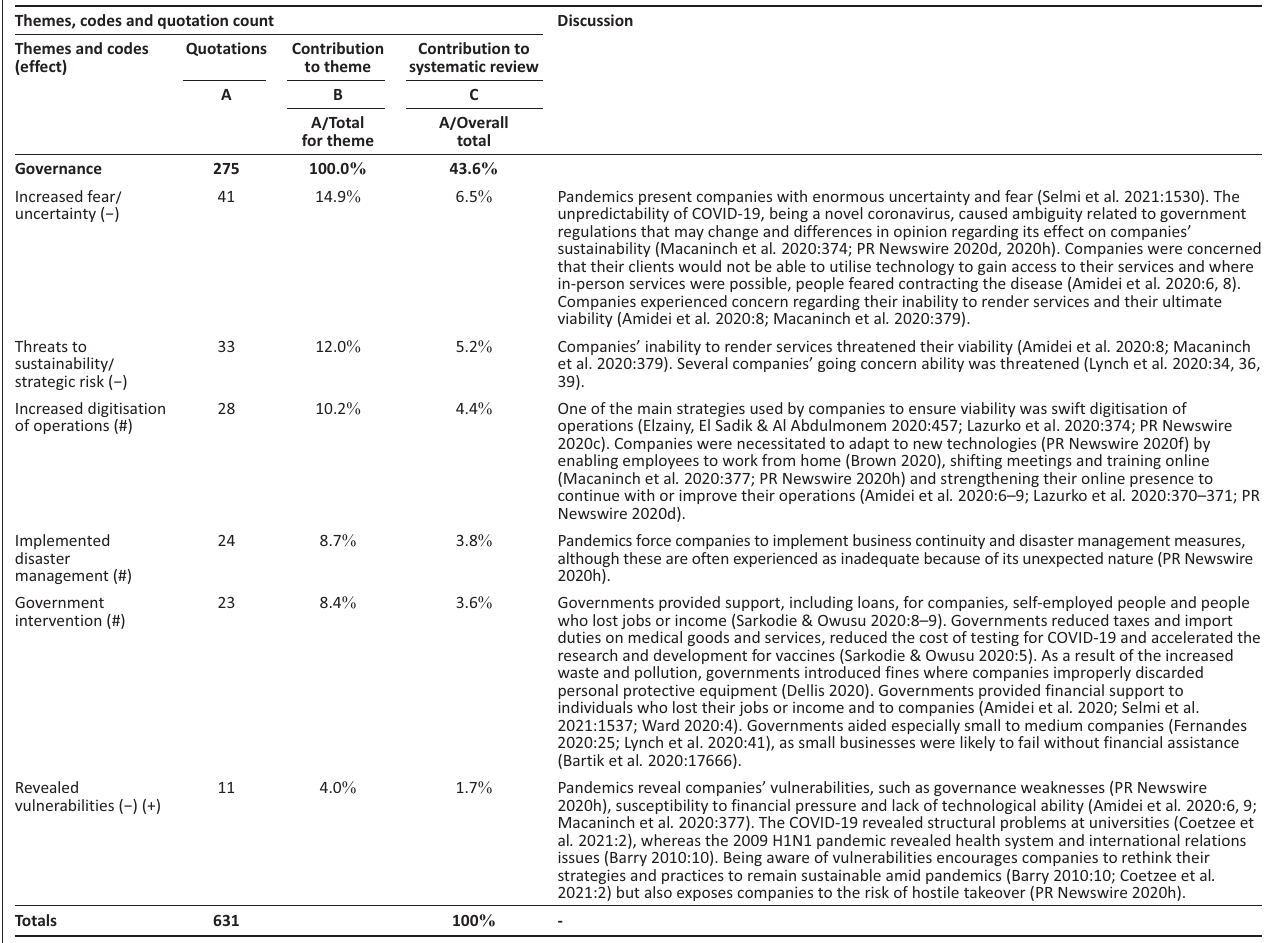
FIGURE 2 (Continues...): Themes, codes, quotation count and